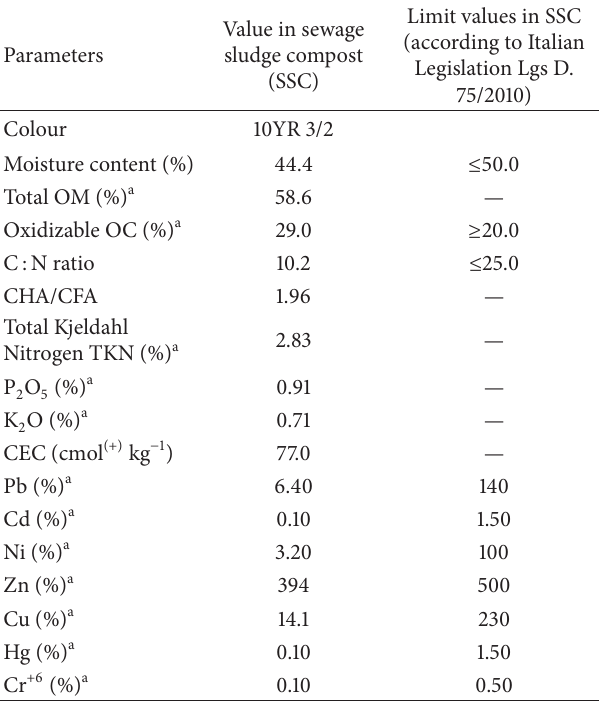
Table 2: Physical and physicochemical characteristics of sewage sludge